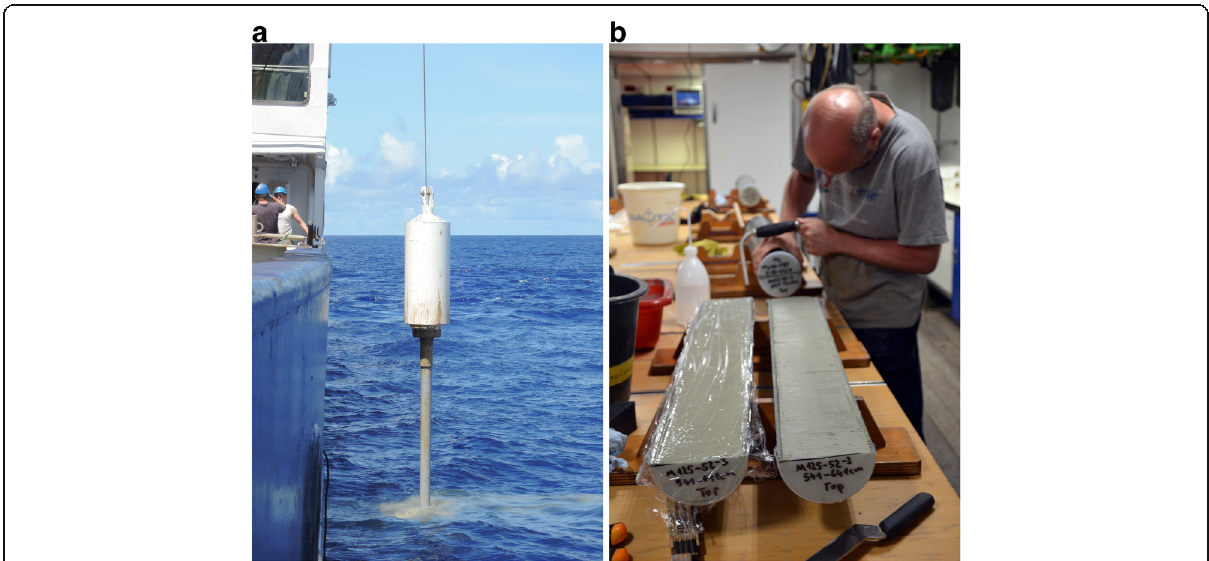
Fig. 1 a Retrieval of sediment cores off the shore of Brazil during the research cruise M125. b Example of a sediment core equivalent to those used in this study, cut in half for sampling of core contents. Samples are only taken from one half of the core, while the other half is archived for reference (photo courtesy of J. Hoffmann)